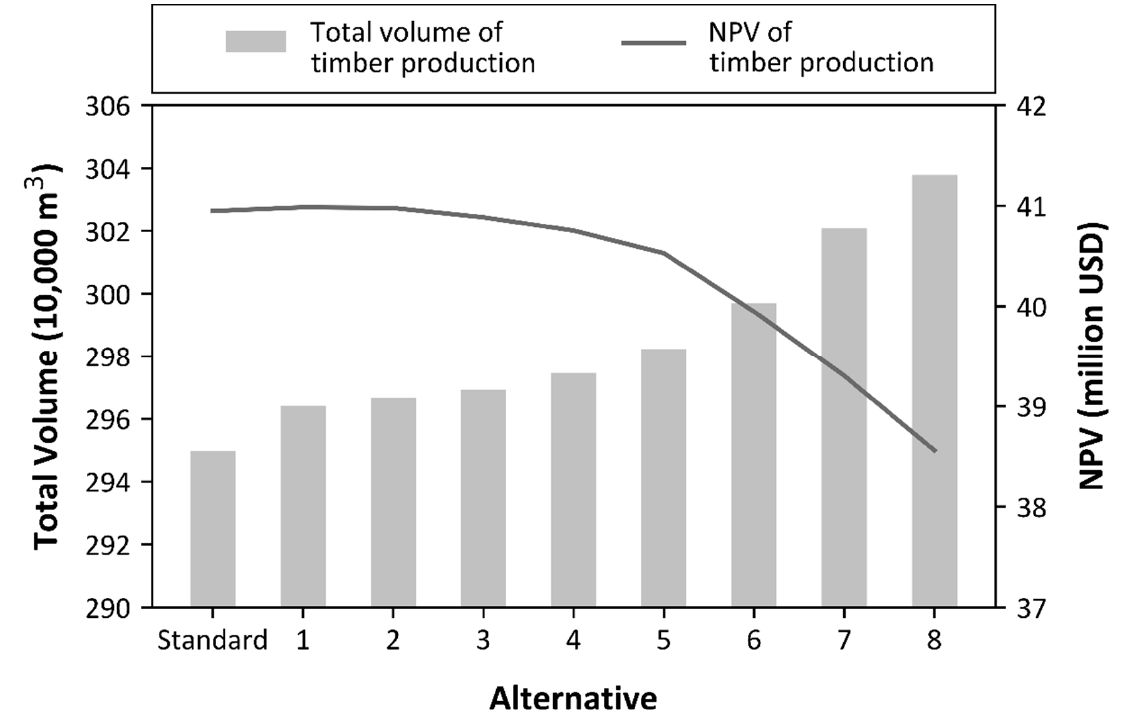
Figure 4. Total volume and NPV of timber production harvested during the entire planning horizon for each management alternative.